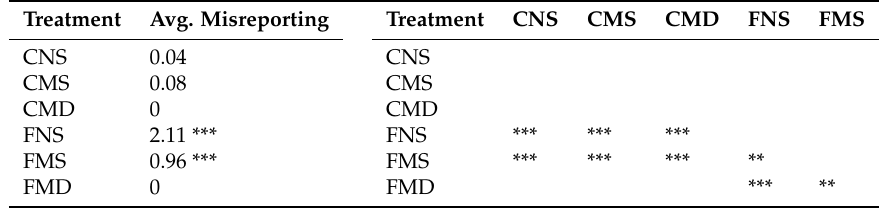
Table A7. Deviation from optimal treatment of Type L Patients across experimental conditions.